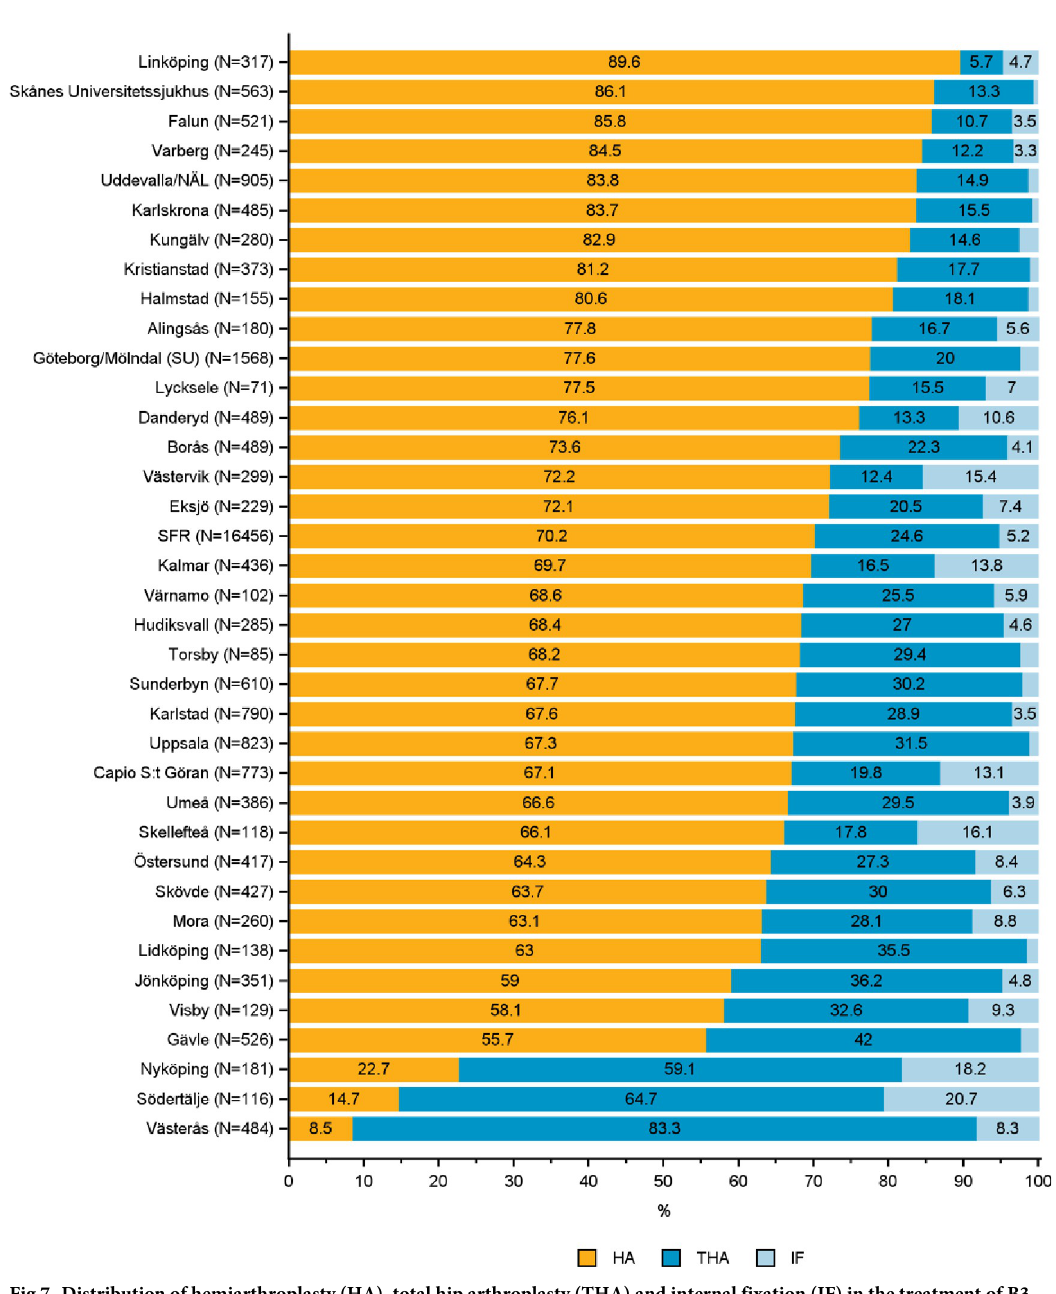
Swedish Fracture Register (distributions are nationwide